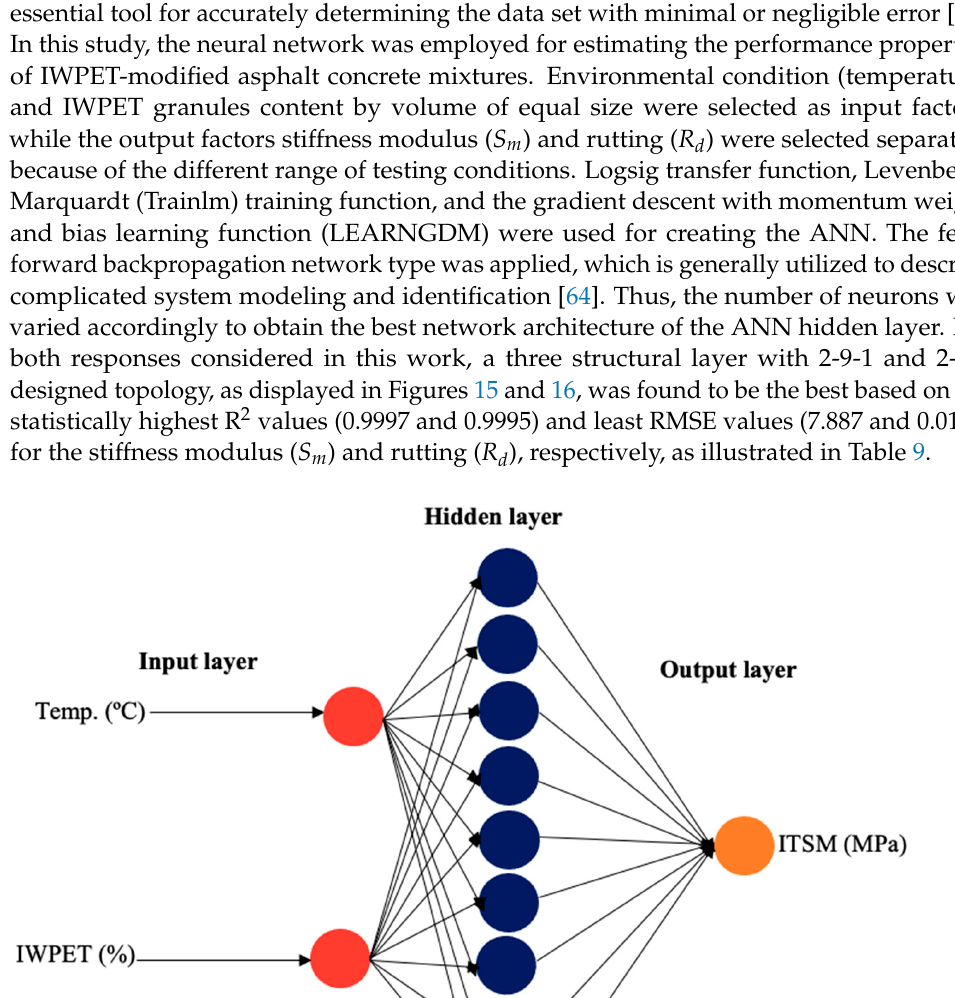
Figure 16. ANN topology for the rutting response of the modified asphalt mix. The respective statistical values of other architectural neurons employed are pre- sented in Table 9. The input neurons comprised the two studied parameters: test temper- ature and IWPET content. The second layer (hidden) represented the ninth and third hid- den neurons, while the third layer (output) was the predicted response for the perfor- mance properties of the modified asphalt concrete mixture, including stiffness modulus ( S m ) and rutting ( R d ), respectively. Table 9. Optimized ANN architecture for input and output factors prediction. No